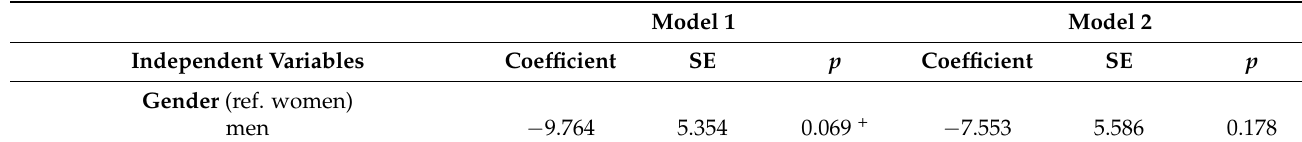
Table 7. Multiple linear regression analysis of job